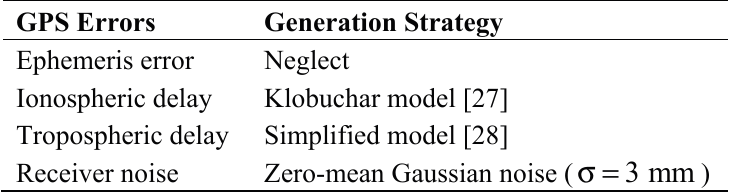
Table 1. GPS simulation generation method.